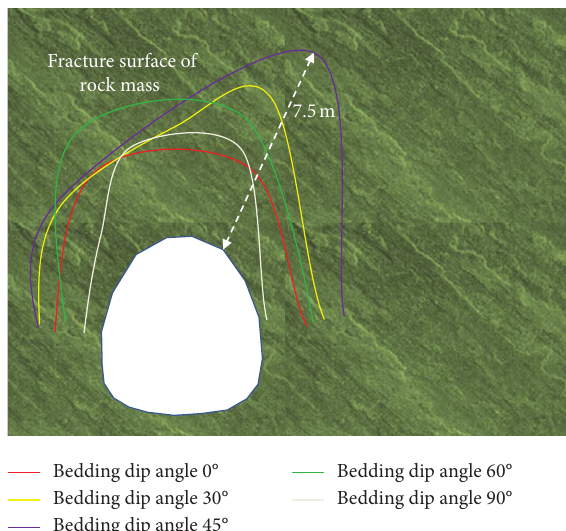
Figure 8: Distribution characteristics of plastic zone of surrounding rock.